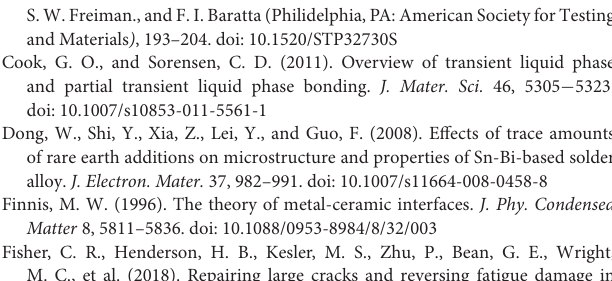
figure development. MM served as advisor to CF, HH, and MK in addition to project design and manuscript